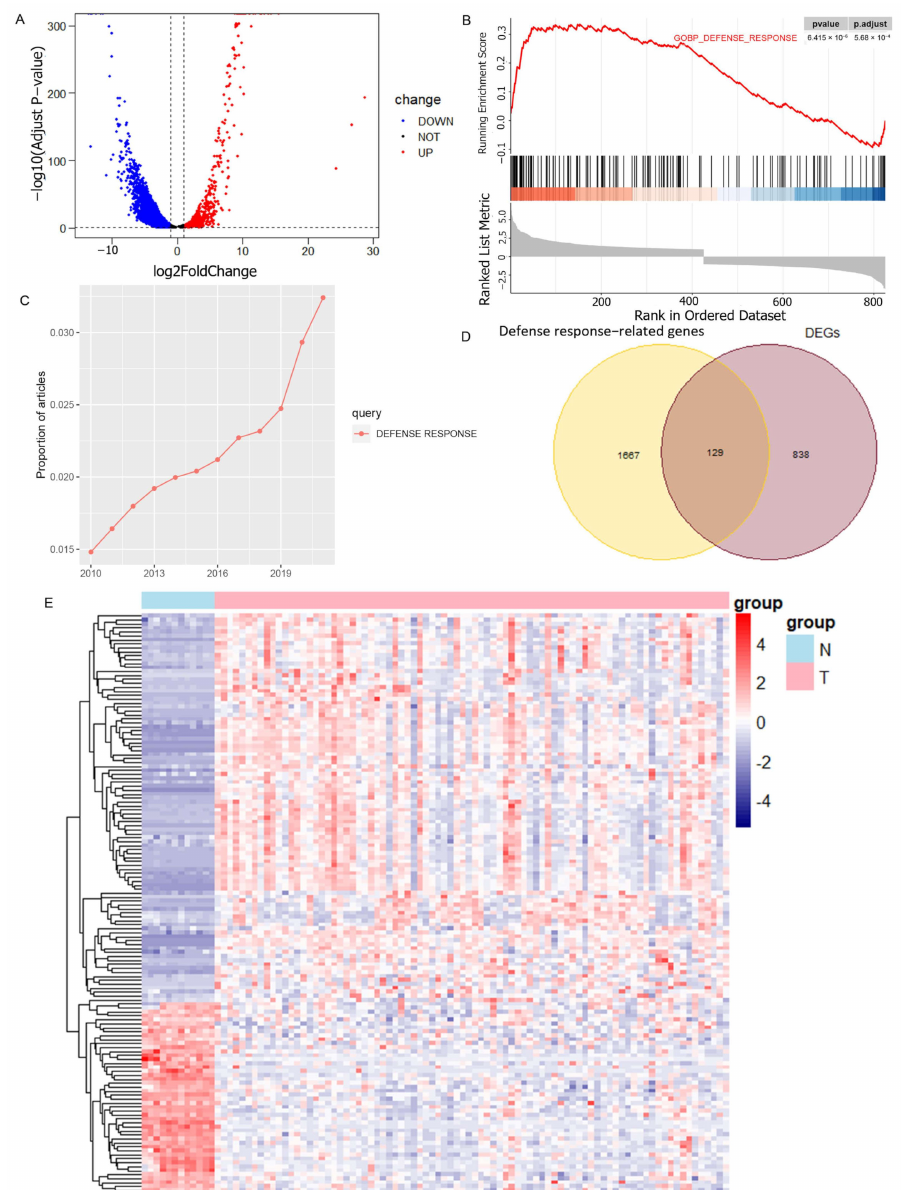
Figure 1. Screening of DEGs related to the defense response. ( A ) Volcano plot illustrating the DEGs in osteosarcoma and normal groups with the threshold set at |logFC| ≥ 1 and adj- p ≤ 0.05. ( B ) DEGs are significantly enriched in the GOBP_DEFENSE_RESPONSE pathway. ( C ) Trend in the number of studies on GOBP_DEFENSE_RESPONSE pathways in recent years. ( D ) DRGs obtained by taking the intersection of DEGs and GOBP_DEFENSE_RESPONSE pathway genes. ( E ) Heatmap showing the expression of DRGs in osteosarcoma samples and normal